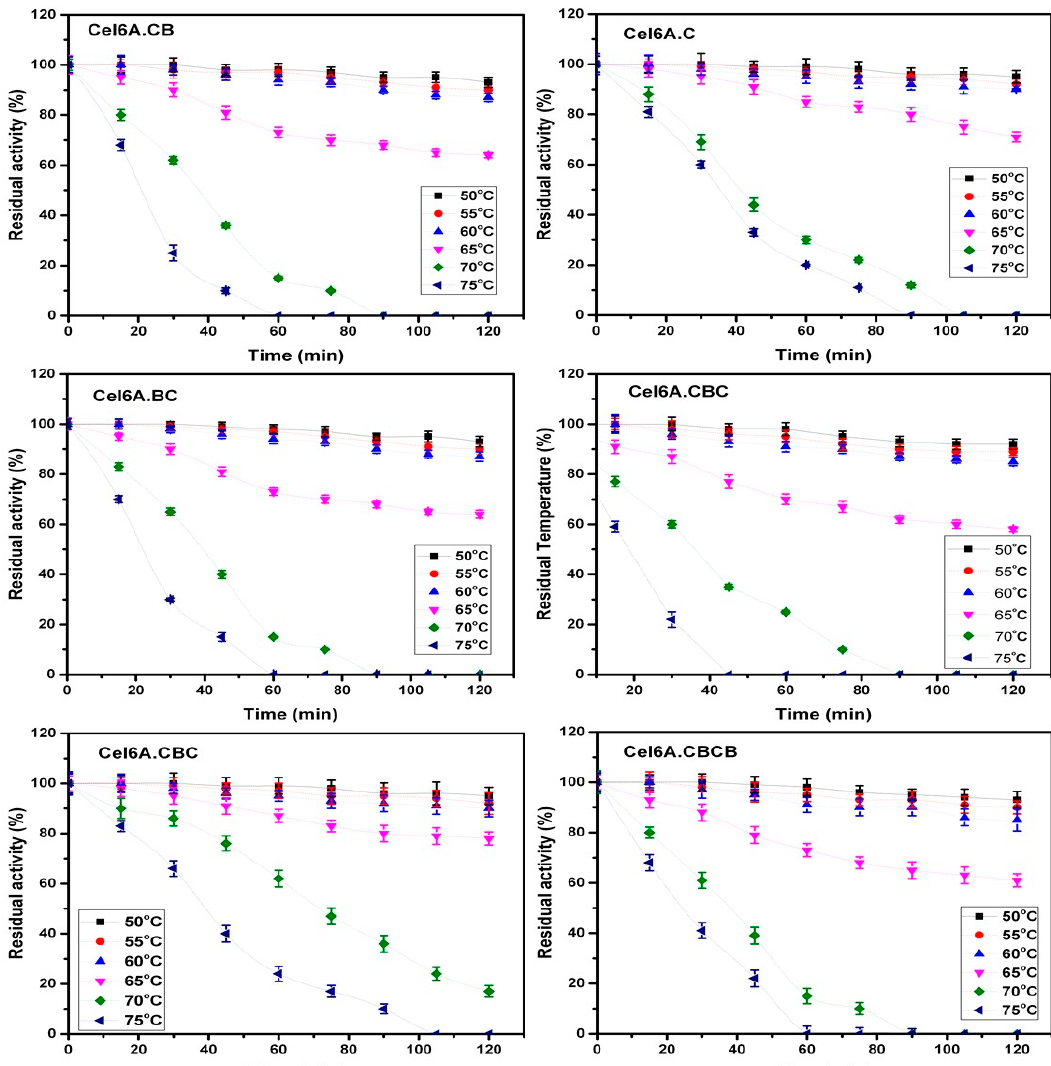
Figure 3. Residual activities of Cel6A variants after incubation at varying temperatures.